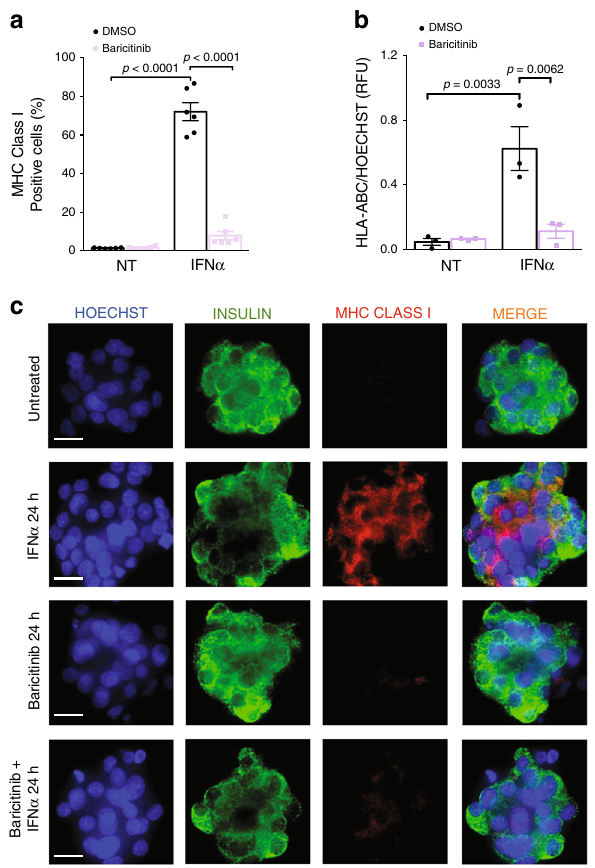
Fig. 9 Baricitinib decreases IFN α -mediated MHC class I protein expression in beta cells. a EndoC- β H1 cells were pretreated with baricitinib (4 μ M) or DMSO and then exposed or not to IFN α for 24h in the presence or not of baricitinib. MHC class I (ABC) protein expression was measured by fl ow cytometry. The percentage of positive cells was quanti fi ed. ( n = 6, mean ± SEM, ANOVA with Bonferroni correction for multiple comparisons). b , c Dispersed human islets were pretreated with baricitinib (4 μ M) or DMSO (vehicle). Next, cells were left untreated, treated with IFN α alone or with IFN α in the presence of baricitinib for 24h. MHC class I intensity was quanti fi ed in each condition ( b ) using Fiji software 80 and normalized by the HOECHST intensity to correct for the number of cell per area ( n = 3, ANOVA with Bonferroni correction for multiple comparisons, RFU (relative fl uorescence units)). Immunocytochemistry (ICC) analysis ( c ) of MHC class I (ABC) (red), insulin (green) and HO (blue) was performed to con fi rm MHC class I expression in three independent human islet